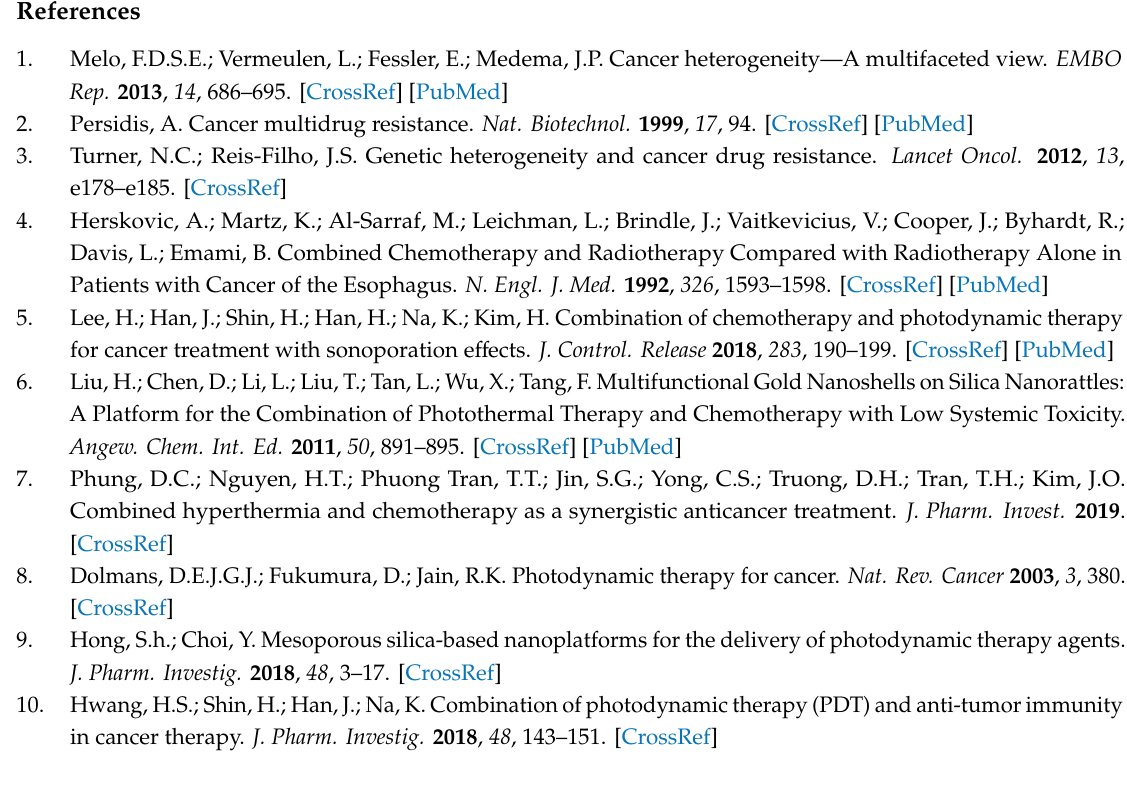
Figure S1: The cell viability of KB cells treated with Lipo (Pep, Ce6) at di ff erent drug loading